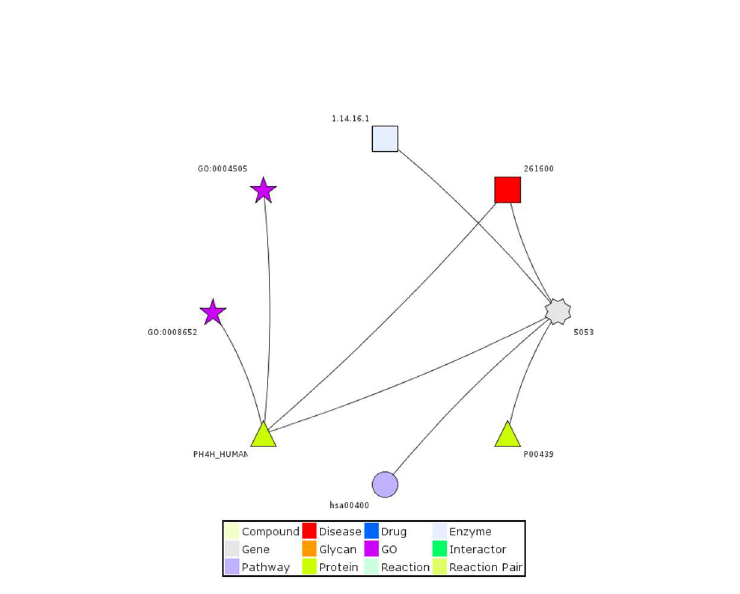
Figure 4: Graph representation of the PH4H HUMAN protein search result with depth 2 (where star symbol represents GO annotations; rectangles are proteins; circles are pahways; red squares are genes; black squares are